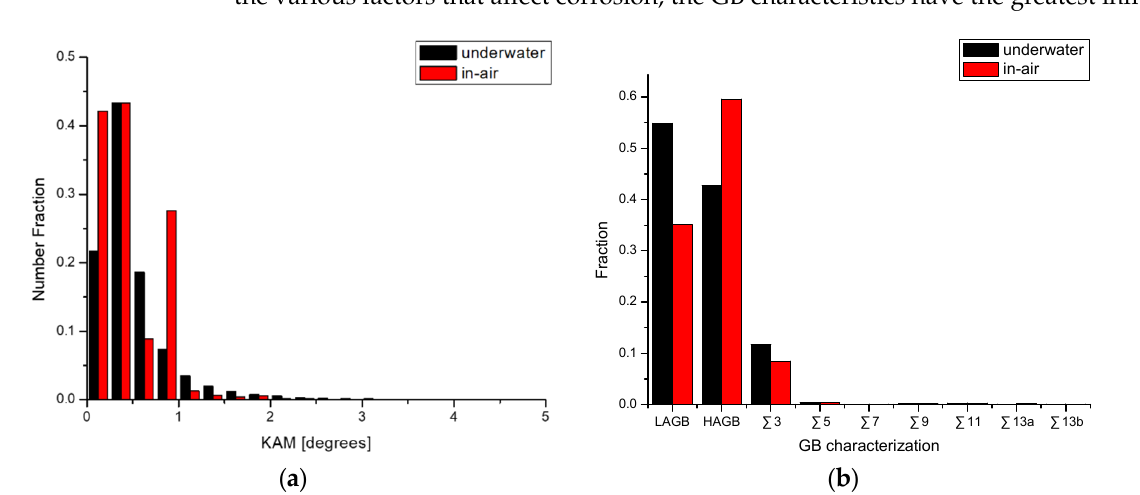
Figure 12. ( a ) Kernel average misorientation values and ( b ) grain boundary fractions in specimens prepared by underwater laser welding and in ‐ air laser welding.